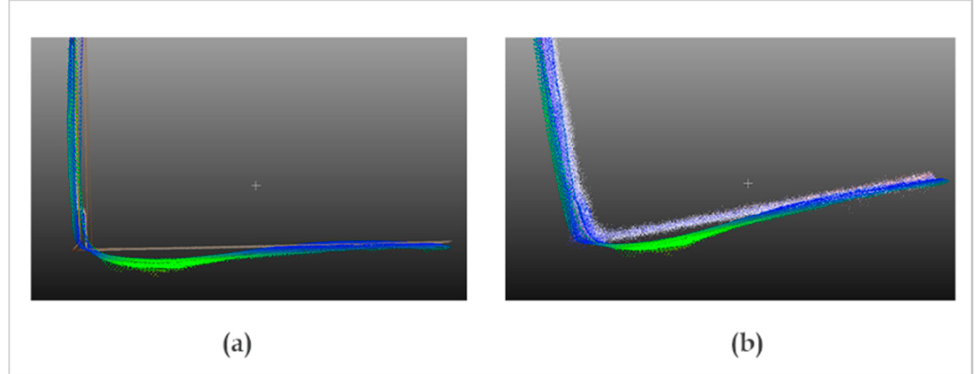
Figure 18. Comparison of the intersection of the wall with the ground. ( a ) TLS (white) vs. Kinect Azure (color), ( b ) MLS (white) vs. Kinect Azure (color).